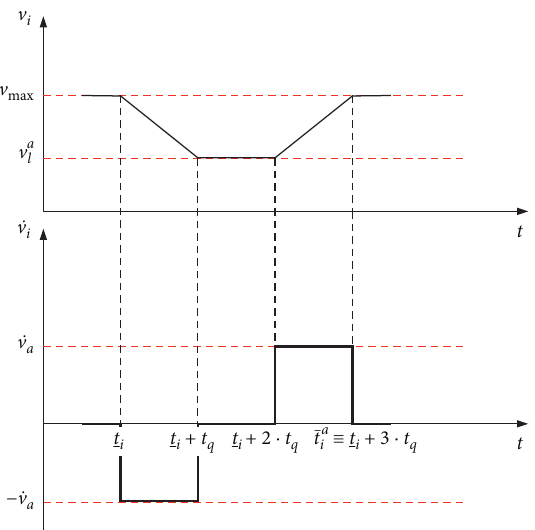
Figure 8: Velocity and acceleration profiles of vehicle A motion of the vehicles is broken down to three distinct periods: constant deceleration, advancement with constant speed, and constant acceleration.